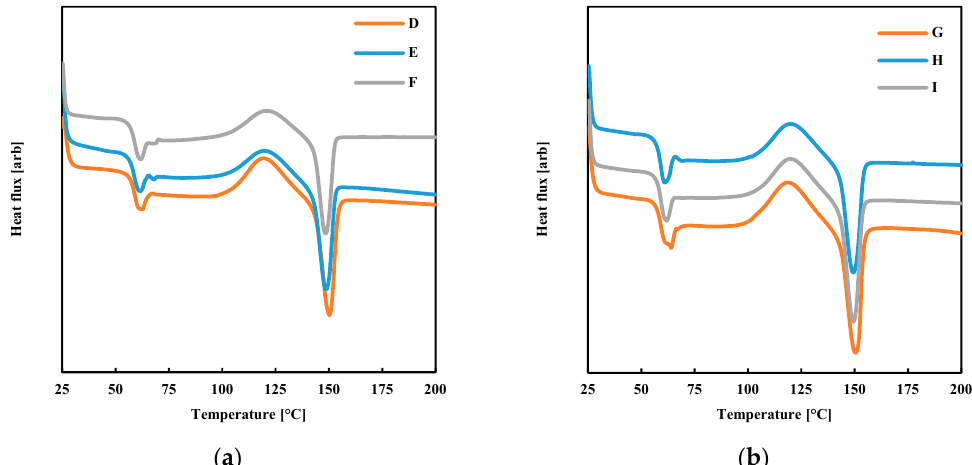
Figure 13. Calorimetric analyses were performed on the specimens obtained by FDM with different T b . ( a ) T n = 200 °C; ( b ) T n = 230 °C.